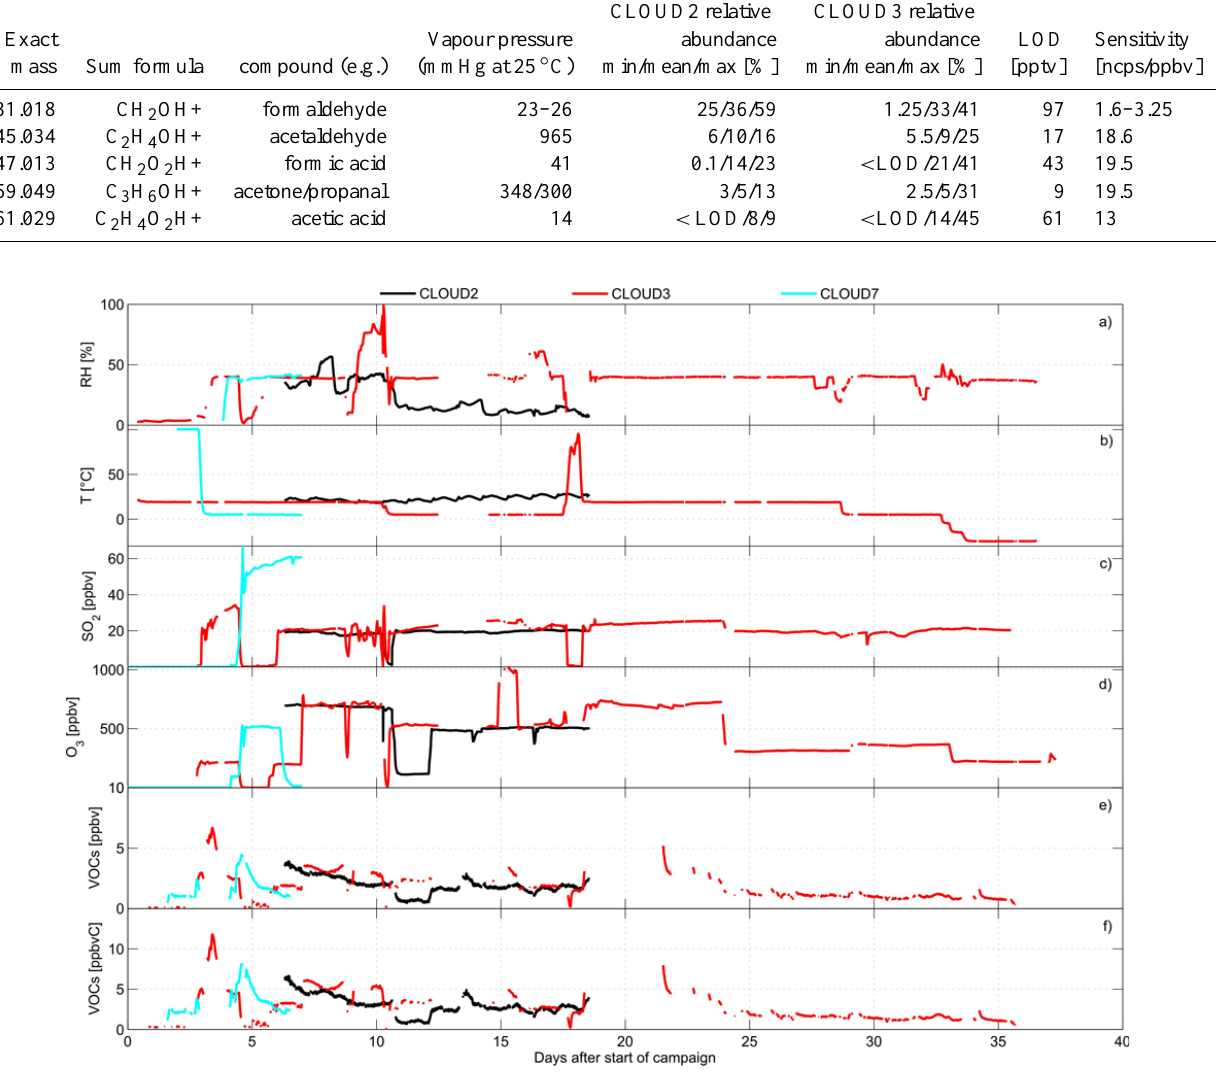
Figure 4. Temporal evolution of relative humidity (a) , temperature (b) , SO 2 (c) , ozone (d) , total VOCs (e) , and total VOCs on a carbon basis (f) during CLOUD2, CLOUD3, and